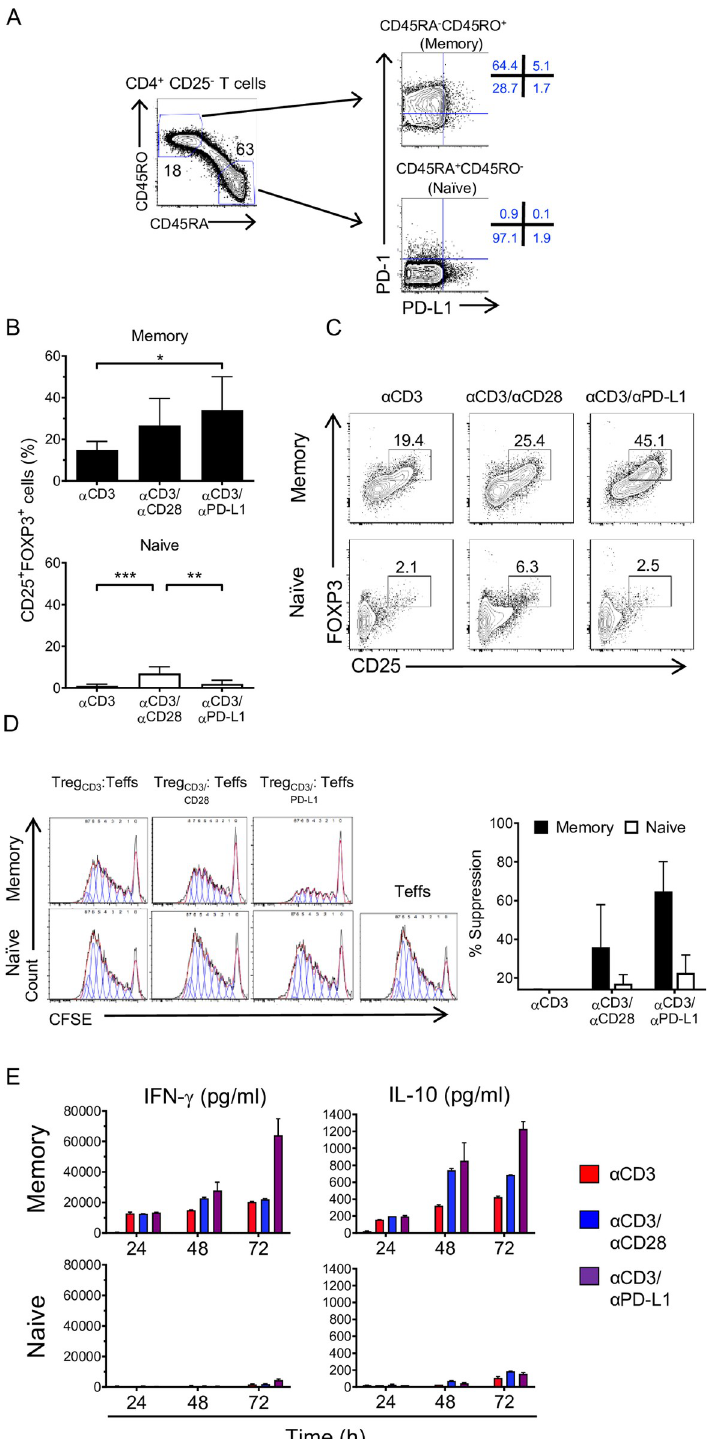
Fig 3. iTreg conversion is induced preferentially in memory cells upon PD-L1 engagement. ( A ) Gating strategy used to sort CD4 + CD25 − T cells in na ï ve and memory subsets based on their CD45RO and CD45RA expression (left panel). Representative plot of sorted populations stained for PD-1 and PD-L1 expression (right panel). ( B ) Quantification of CD25 and FOXP3 expression on memory (upper panel) ( n = 4) and na ï ve (bottom panel) ( n = 7) subsets following 72 h of activation with α CD3, α CD3/ α CD28, and α CD3/ α PD-L1. Bars represent the mean ±